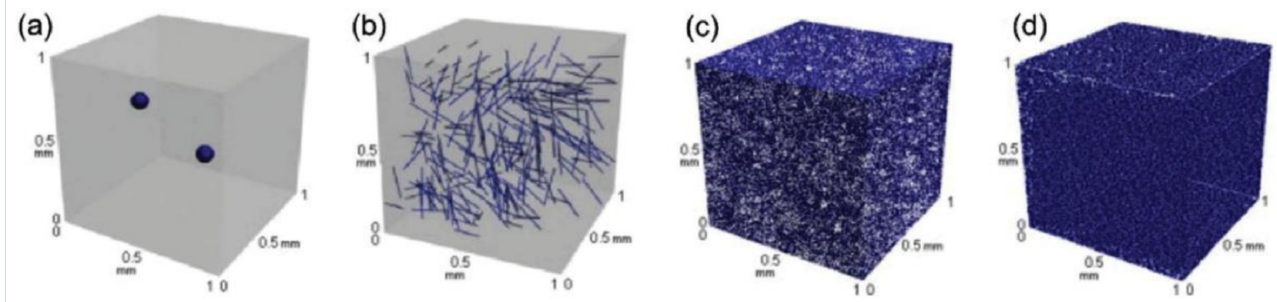
Figure 2. Distribution of micro- and nano-scale fillers: ( a ) Al 2 O 3 particle, ( b ) carbon fiber, ( c ) graphene nano-platelets (GNPs), and ( d ) CNTs. Adapted from